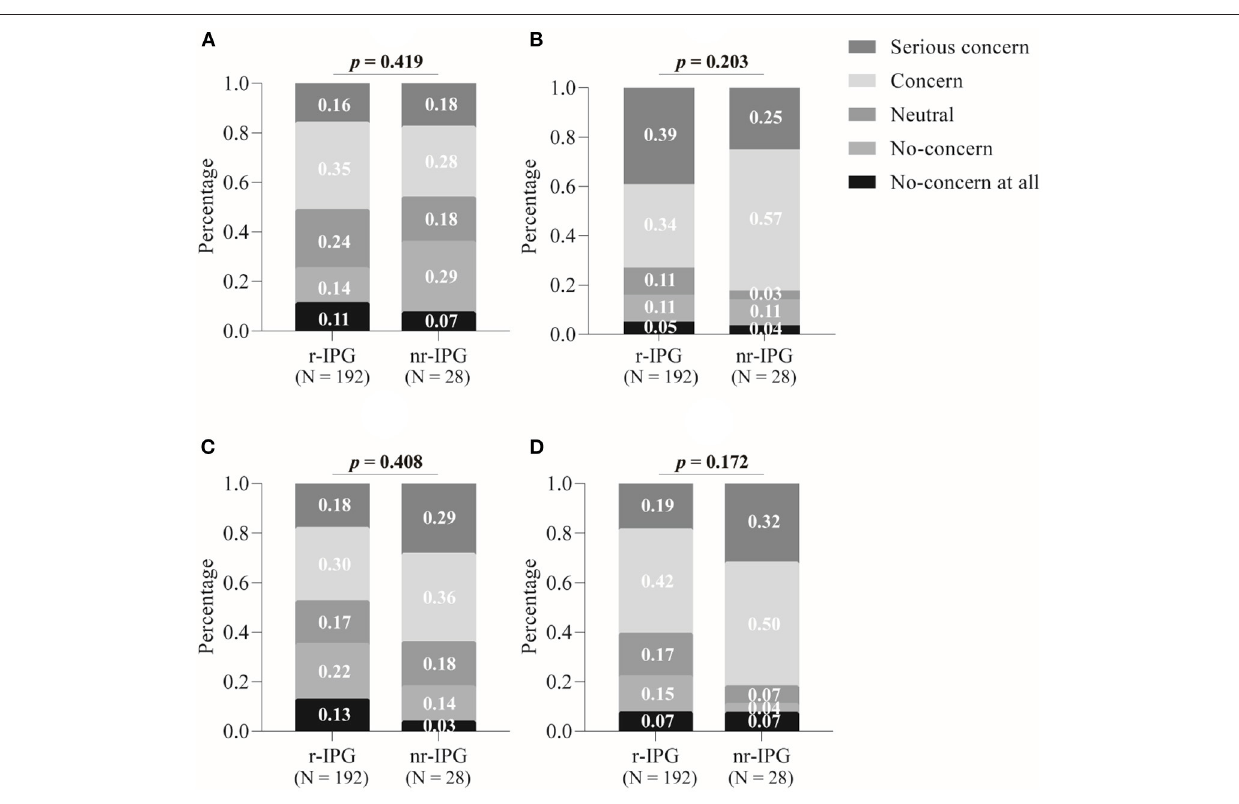
binomial test showed that these two sample proportions differed significantly from each other ( z = 2.2, p = 0.031) ( Figure 2D